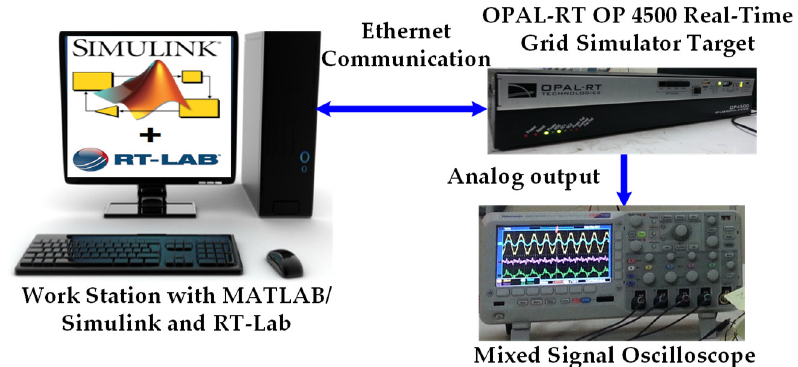
Figure 12. Laboratory test setup of real-time (RT) software in loop (SIL) validation.